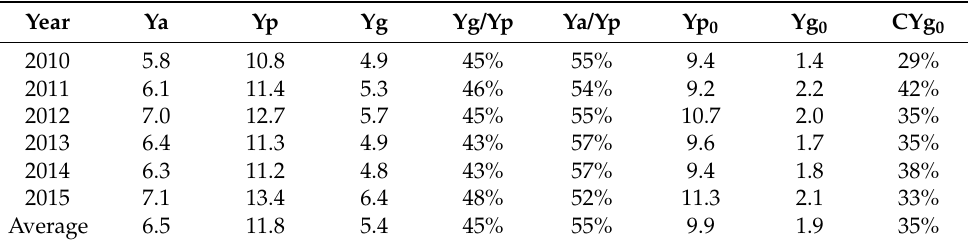
Table 1. Ya, potential yield limited by suboptimal SDT (Yp 0 ), Yp, Yg, ratio of Yg to Yp (Yg/Yp), ratio